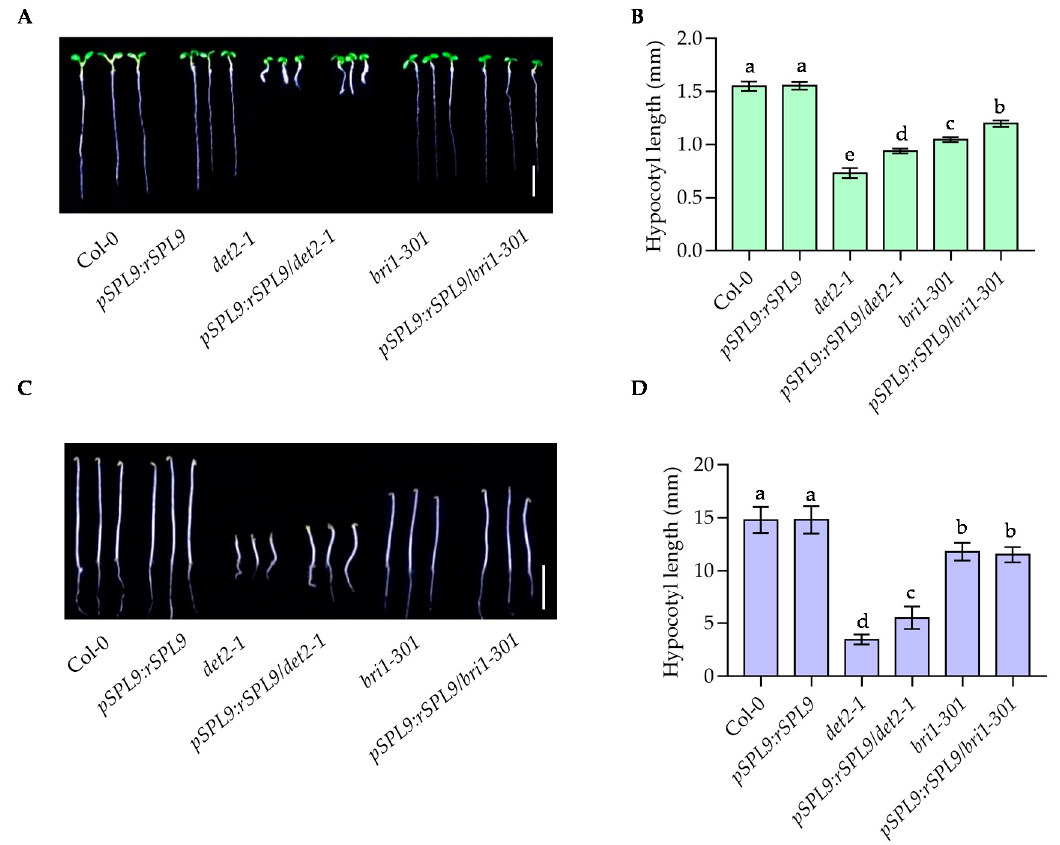
Figure 3. The dwarf phenotypes of det2-1 and bri1-301 were partially suppressed by the pSPL9:rSPL9 transgenic plants. ( A , B ) Seedlings of wild type and indicated plants were grown under constant light for 7 days. Hypocotyl lengths were measured from at least 30 plants. Error bars represent standard deviation. Different letters above the bars indicated statistically significant differences between the samples (ANOVA analysis followed by Uncorrected Fisher’s LSD (Least-significant difference) multiple comparisons test, p < 0.05). ( C , D ) Seedlings of wild type and indicated plants were grown in the dark for 7 days. Hypocotyl lengths were measured from at least 30 plants. Error bars represent standard deviation. Different letters above the bars indicated statistically significant differences between the samples (ANOVA analysis followed by Uncorrected Fisher’s LSD multiple comparisons test, p < 0.05).